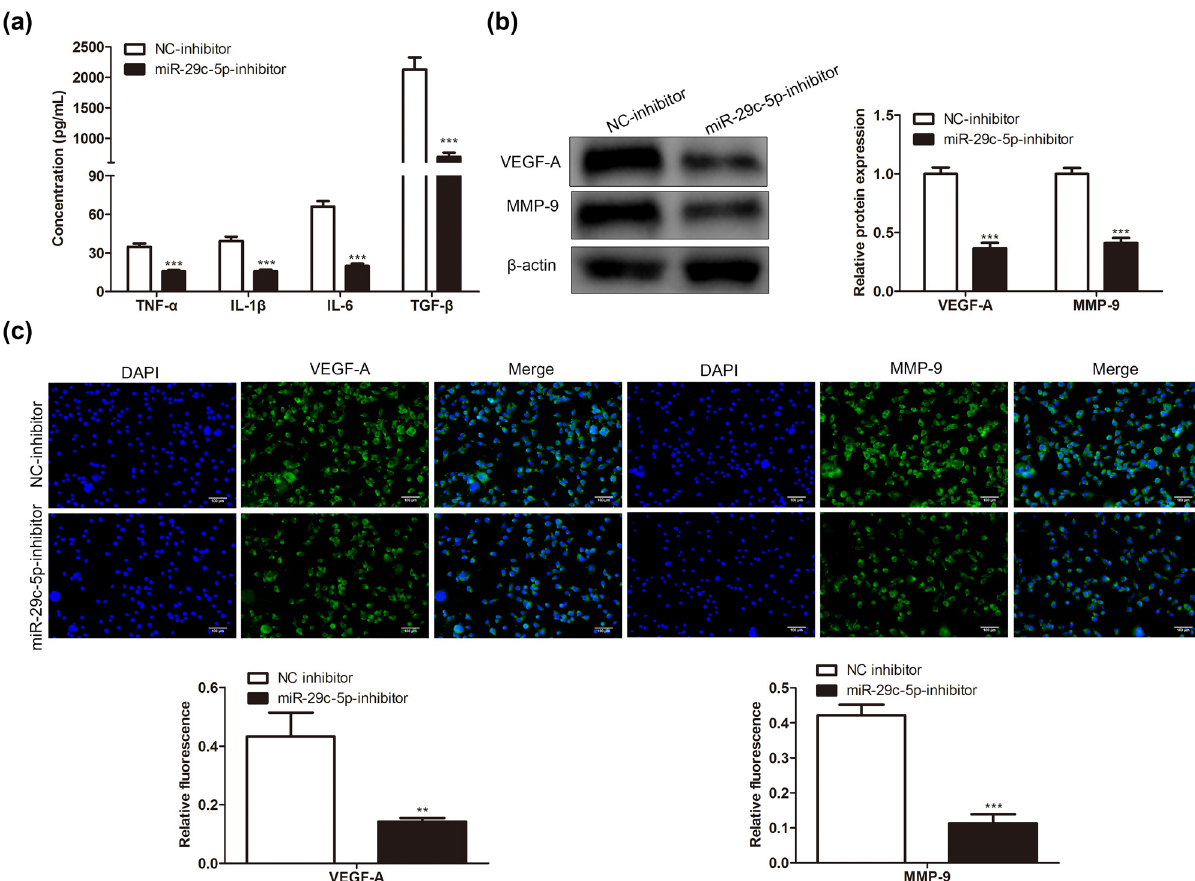
Figure 4: E ff ect of miR - 29c - 5p on the in fl ammation caused by OGD - treated astrocytes. Astrocytes transfected with miR - 29c - 5p inhibitor or NC - inhibitor were treated with OGD for 3 h. ( a ) ELISA was performed to test the concentrations of in fl ammatory cytokines IL - 1 β , IL - 6, TNF - α , and TGF - β in cell culture supernatant of astrocytes. ( b ) The protein levels of in fl ammatory factors VEGF - A and MMP - 9 were tested using Western blot. ( c ) An immuno fl uorescence assay was performed to assess the expressions of VEGF - A and MMP - 9 ( scale bar: 100 µm ) . Data are presented as an average of three independent assays. ** P < 0.01, *** P < 0.001 vs NC -